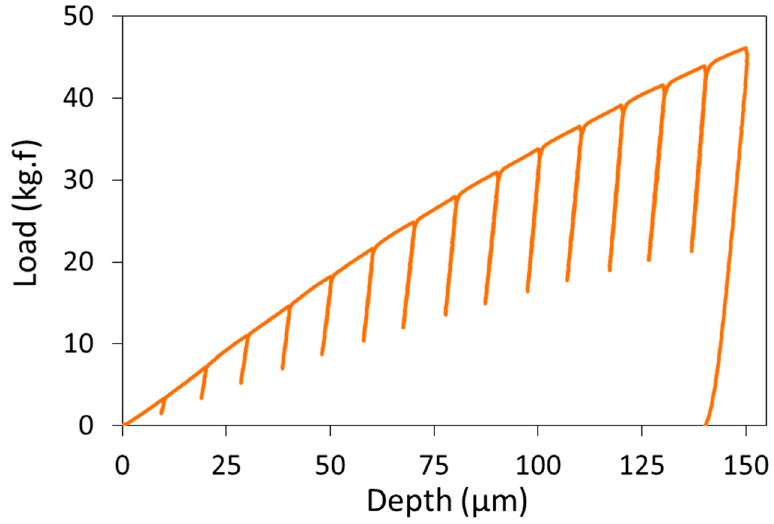
Figure 1. Photograph of the Frontics AIS 2100 IIT instrument mounted to a pipe sample.